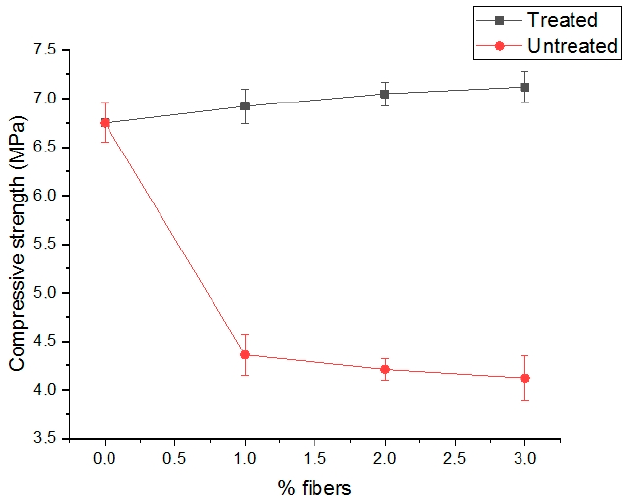
Figure 3. Compressive strength of mortars.